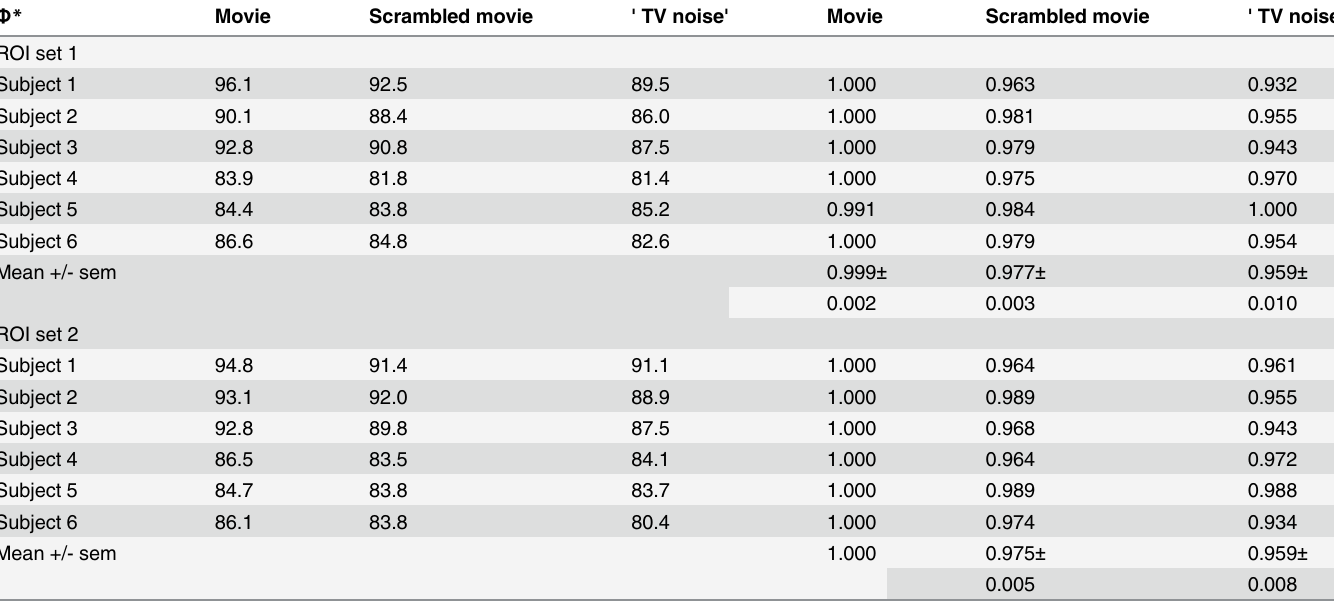
Table 4. Integrated information Φ * results.